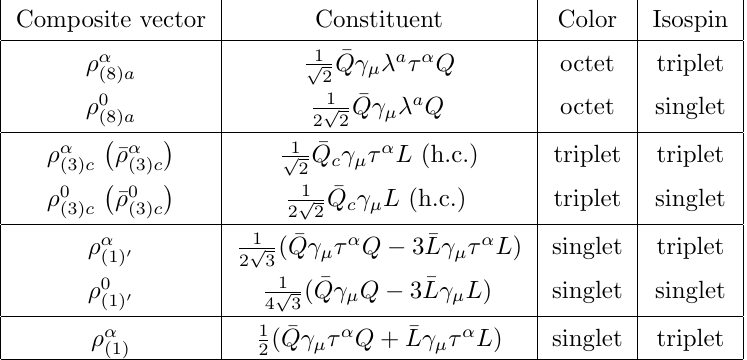
Table 2 . The HC rho mesons and their associated constituent HC quarks Q c = ( U; D ) c and leptons L = ( N; E ). Here (cid:21) a ( a = 1 ; (cid:1) (cid:1) (cid:1) ; 8) are the Gell-Mann matrices, (cid:28) (cid:11) SU(2) generators de(cid:12)ned as (cid:28) (cid:11) = (cid:27) (cid:11) = 2 ( (cid:11) = 1 ; 2 ; 3) with the Pauli matrices (cid:27) (cid:11) , and the label c stands for the QCD-three colors, c = r; g; b . The numbers attached in lower scripts (1 ; 3 ; 8) correspond to the representations under the QCD color, i.e., singlet, triplet and octet for (1 ; 3 ; 8). Since the unbroken color symmetry acts as an internal degree of freedom, four color-octet (real), four color-triplet (complex), and seven color-singlet (real) states are observed as distinguishable